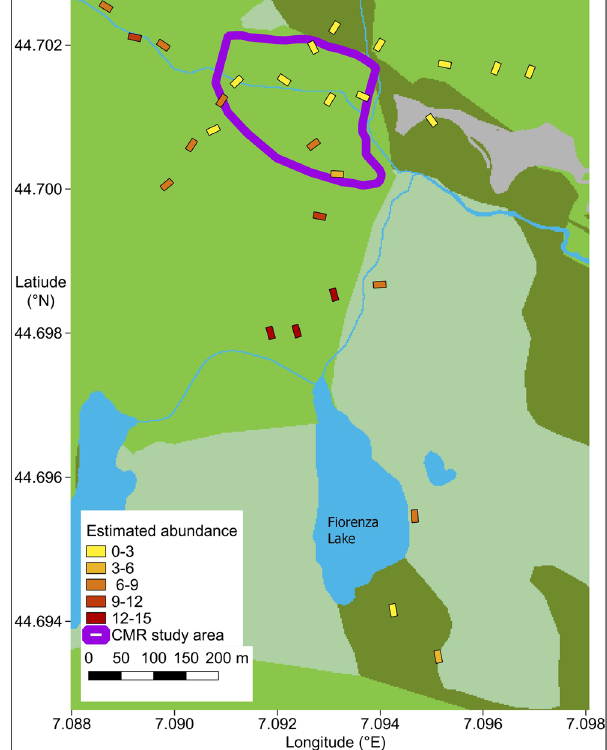
Figure 1. Plots used to assess the abundance of Salamandra lanzai , and spatial variation of abundance estimates. The violet line is the approximate limit of the area sampled with capture-mark-recapture 42 . The map was generated by GFF using the open-source software QGis 2.18 (QGIS Development Team, 2016. QGIS Geographic Information System. Open Source Geospatial Foundation Project. www.qgis.org); background colors represent land use (grey: built-up; green: pasture; pale green: sparse vegetation; dark green: high-altitude pasture and moorland; blue: water).